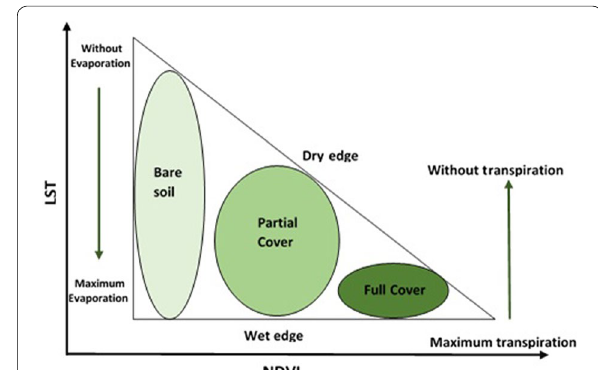
Fig. 8 Simplified LST/NDVI (Reproduced with permission from Lam- bin and Ehrlich 1996; Sandholt et al. 2002)